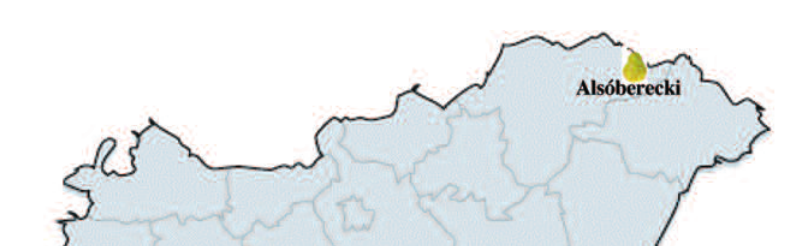
Figure 1. The examined pear varieties (‘Bosc Beurre’and ‘Williams’)